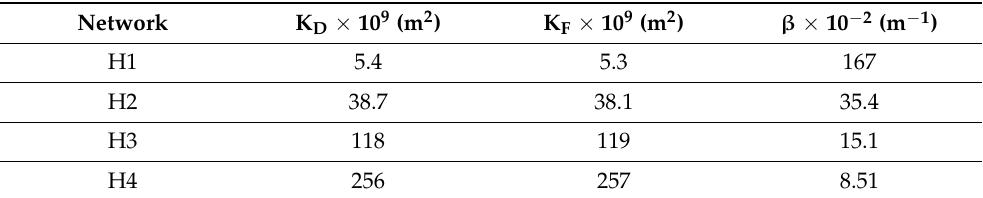
Table 2. Darcy and Forchheimer parameters for